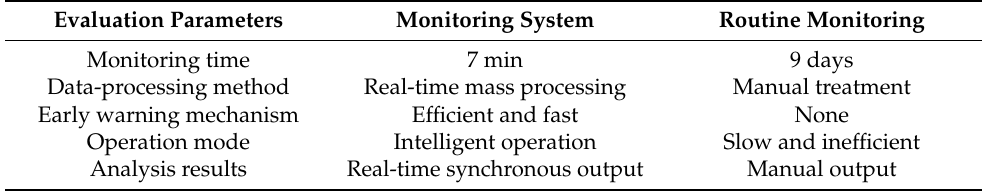
Table 5. Comparison between the control system and the traditional monitoring